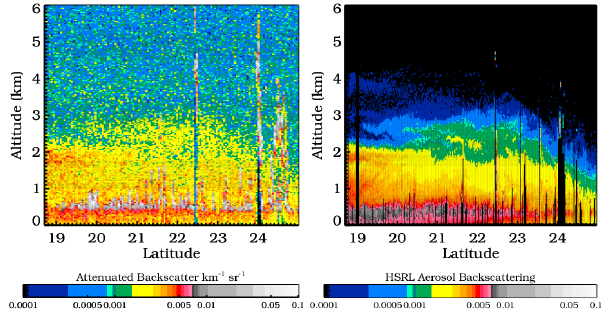
Fig. 1. Total attenuated backscatter at 532nm measured by CALIOP is shown (left panel) for a portion of a nighttime scene in the Caribbean Sea on 24 August 2010 which includes advected Saha- ran dust. The CALIPSO satellite transited this scene in 1.7min. The data includes 5km horizontal smoothing, similar to online browse images available at http://eosweb.larc.nasa.gov/PRODOCS/calipso/ table calipso.html through the NASA Langley Atmospheric Sci- ence Data Center. Also shown (right) is the aerosol backscatter co- efficient at 532nm for the same scene as measured by the LaRC airborne HSRL-1 instrument on a coincident underflight. The tran- sit time for the B200 with HSRL aboard was